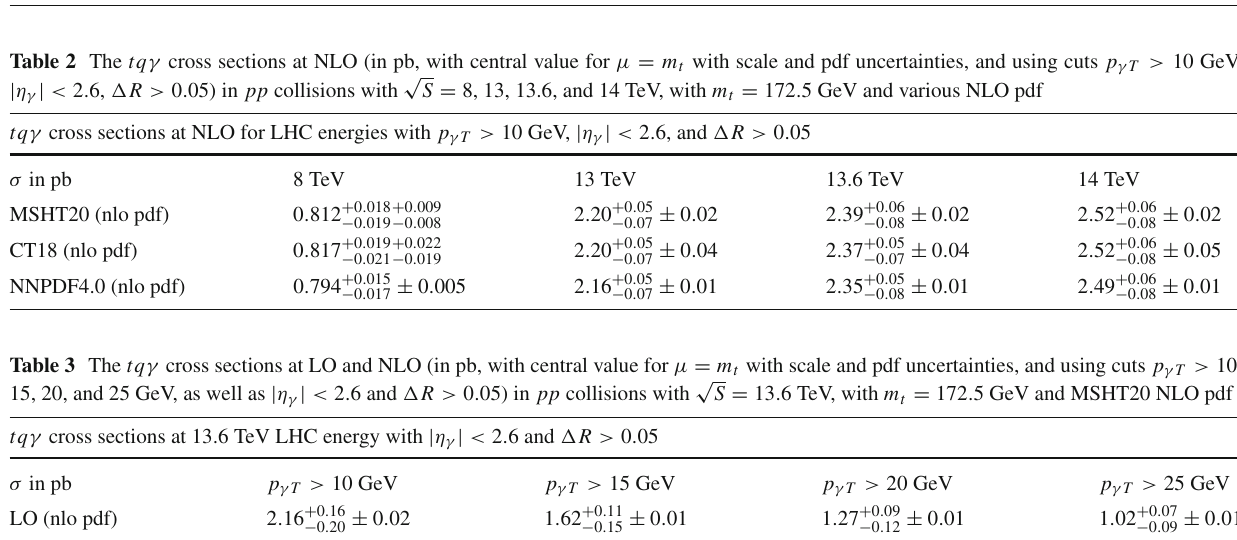
Table 1 The tq γ cross sections (in pb, with μ = m t , p γ T > 10 GeV, | η γ | < 2 . 6, (cid:7) R > 0 . 05) in pp collisions with 50, and 100 TeV, m t = 172 . 5 GeV, and MSHT20 pdf tq γ cross sections in pp collisions with p γ T > 10 GeV, | η γ | < 2 . 6, and (cid:7) R > 0 . 05